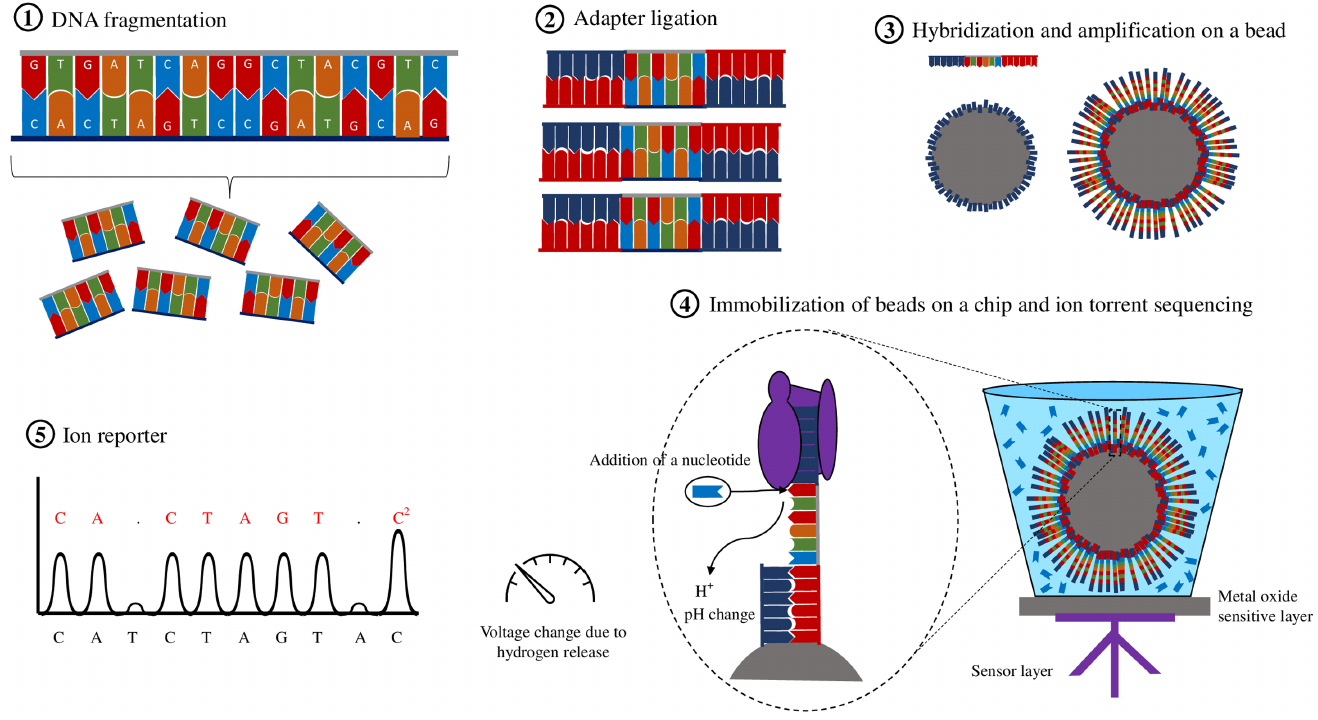
Figure 5. Ion Torrent sequencing and ion reporter (G: guanine, A: adenine, C: cytosine, T: